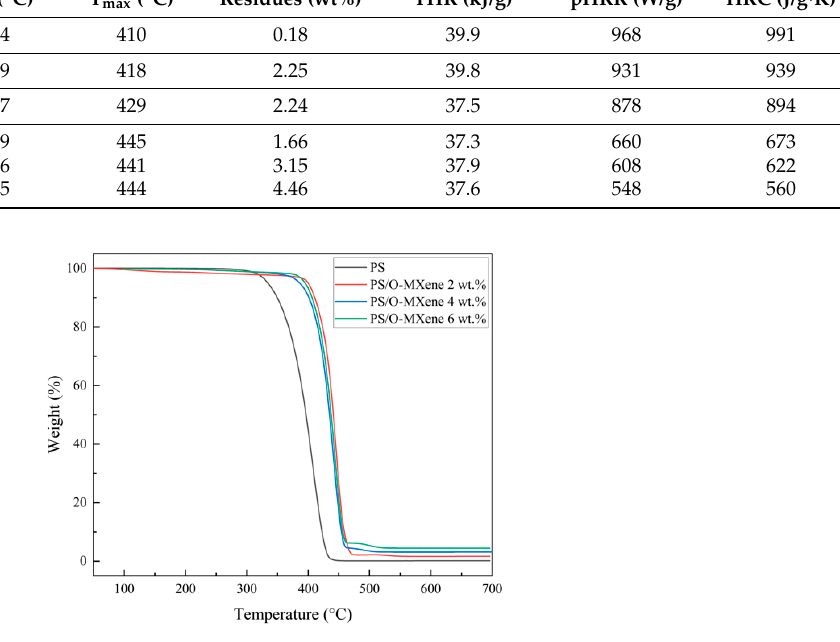
Figure 3. TGA curves of PS and PS/O-Ti 3 C 2 nanocomposites with different weight ratios.